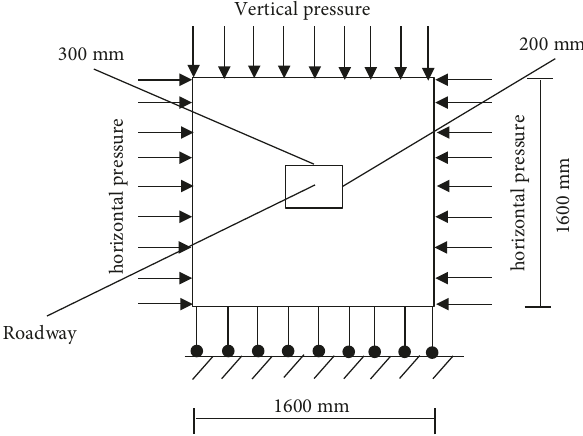
Figure 2: Loading boundary pressure conditions. Table 3: Loading scheme of model